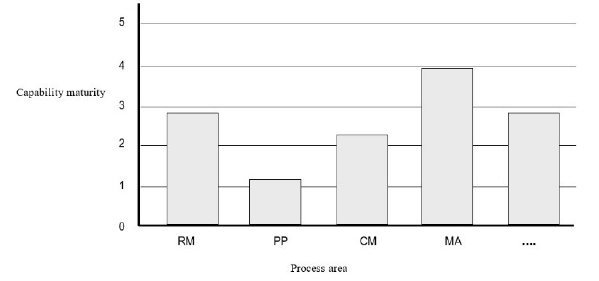
Figure 2. CMMI continuous presentation of capability